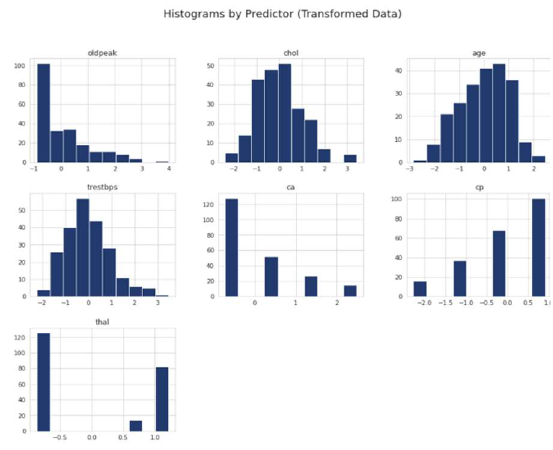
Figure 4: Heart Histogram Attribute